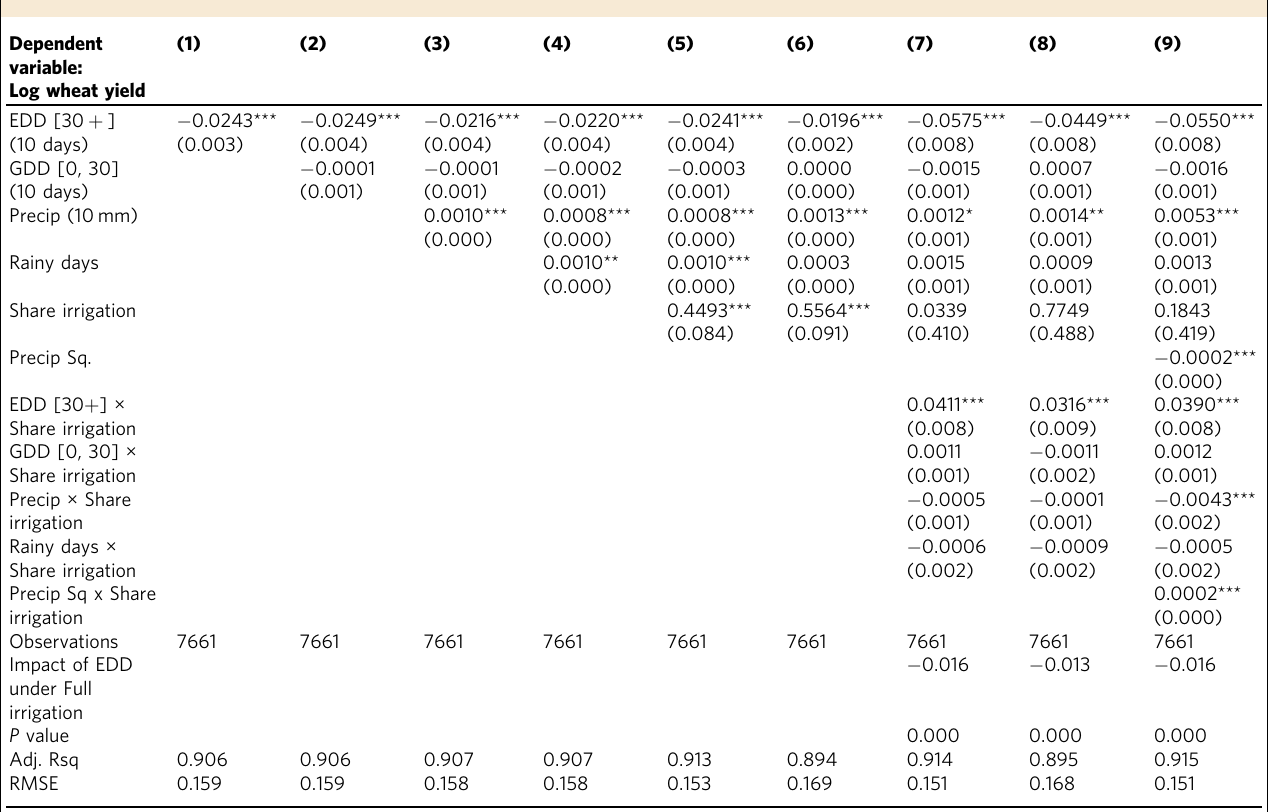
Table 1 Impact of weather and irrigation on log wheat yield Dependent variable: